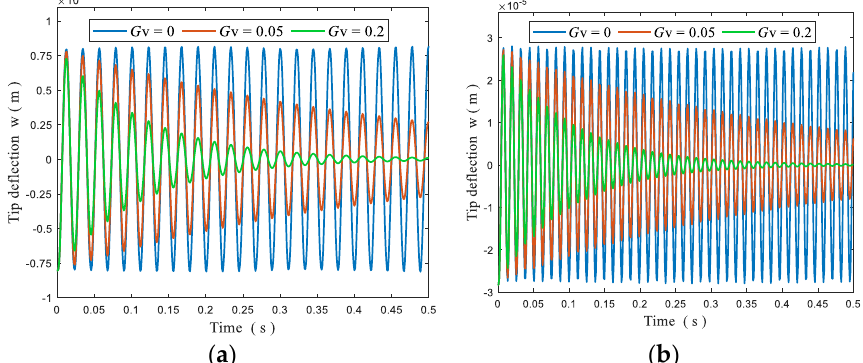
Figure 16. The tip transient deflection of a CFFF PFGP under an initial uniformly distributed load of